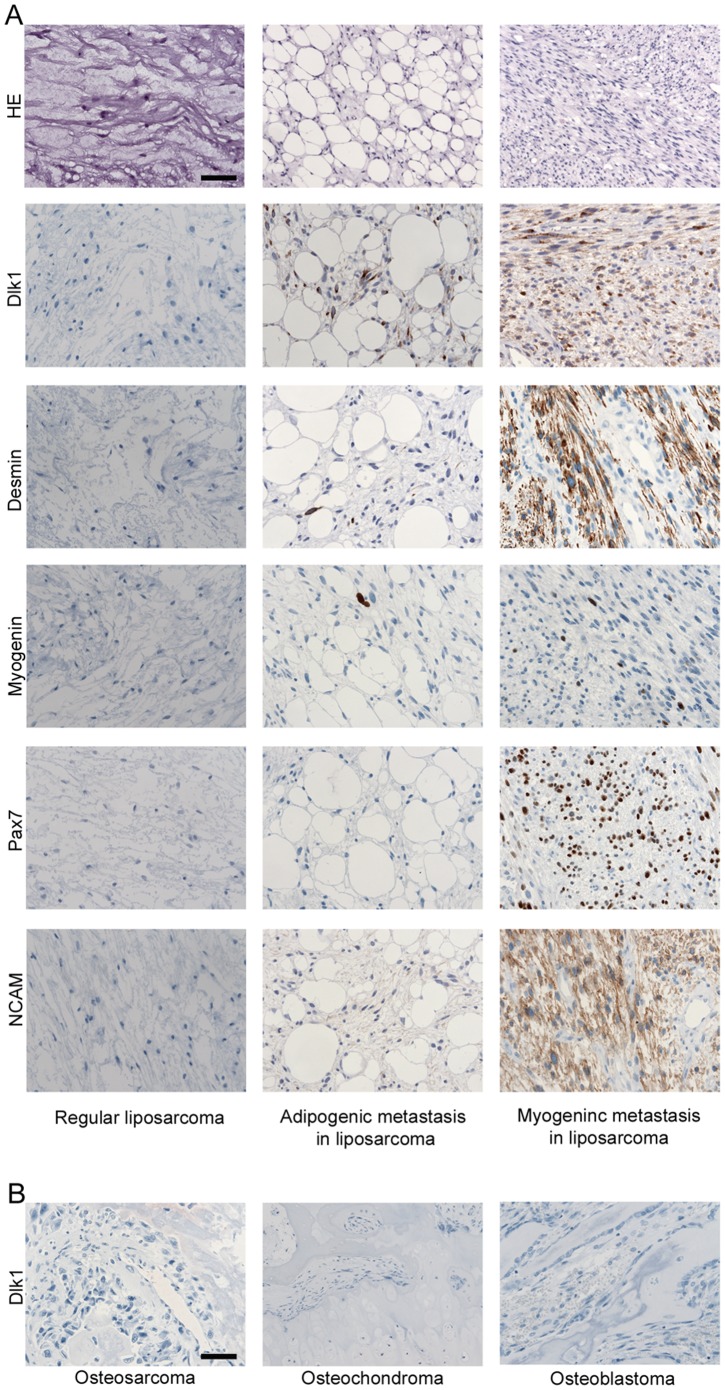
Immunohistochemical analysis of tumors with adipogenic or osteogenic origin.A: A biopsy from a liposarcoma with an adipogenic and a myogenic metastasis was investigated for expression of Dlk1, Desmin, Myogenin, Pax7 and NCAM. All myogenic markers were predominantly detected in the myogenic metastasis and not in the main liposarcoma or the adipogenic metastasis. Accordingly, Dlk1 was primarily expressed in the myogenic metastasis. Few Dlk1 positive cells could, however, be detected in the adipogenic metastasis, where few cells were found to express Desmin and Myogenin as well. This supports the observation that Dlk1 is a strong marker for tumors with skeletal muscle phenotype. Scalebar representative for all images: 50 µm. B: Biopsies from tumors with osteogenic origin were analyzed for expression of Dlk1 and all types analyzed (osteosarcoma, osteochondroma and osteoblastoma), were negative for Dlk1 protein expression. Scalebar representative for all images: 50 µm.